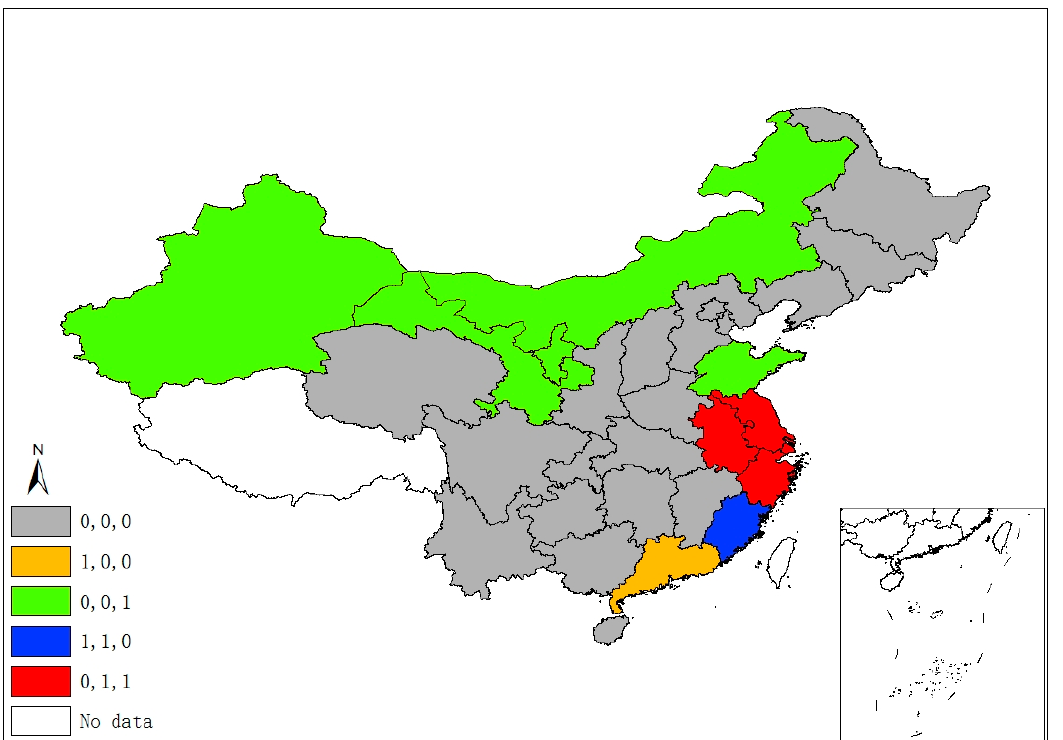
Figure 3. Spatiotemporal significant spots of foreign direct investment (FDI).